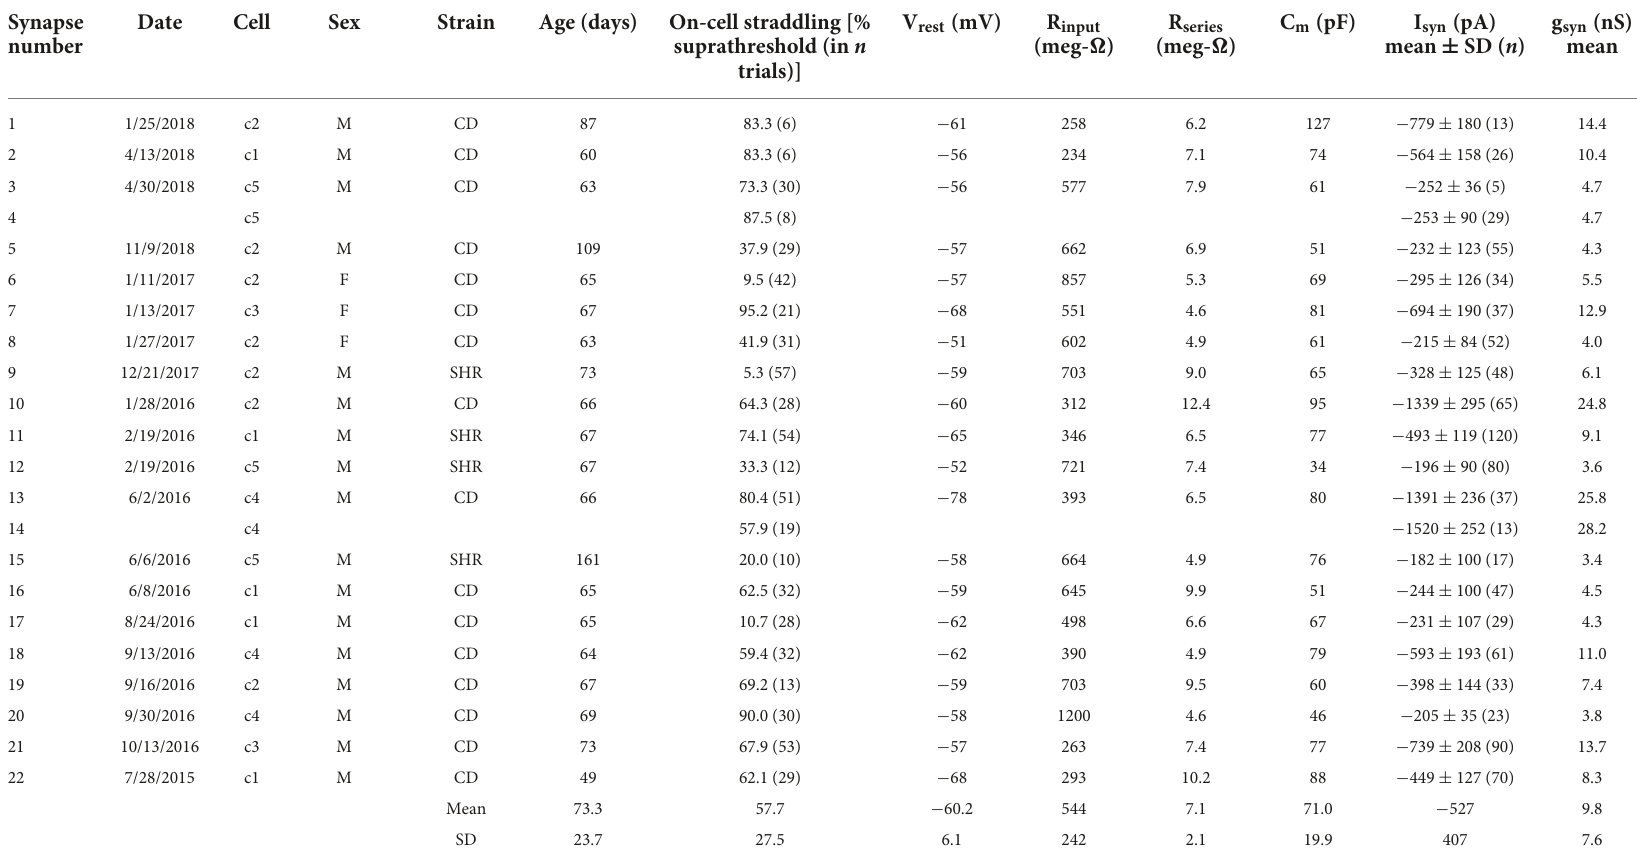
TABLE 2 Summary of straddling